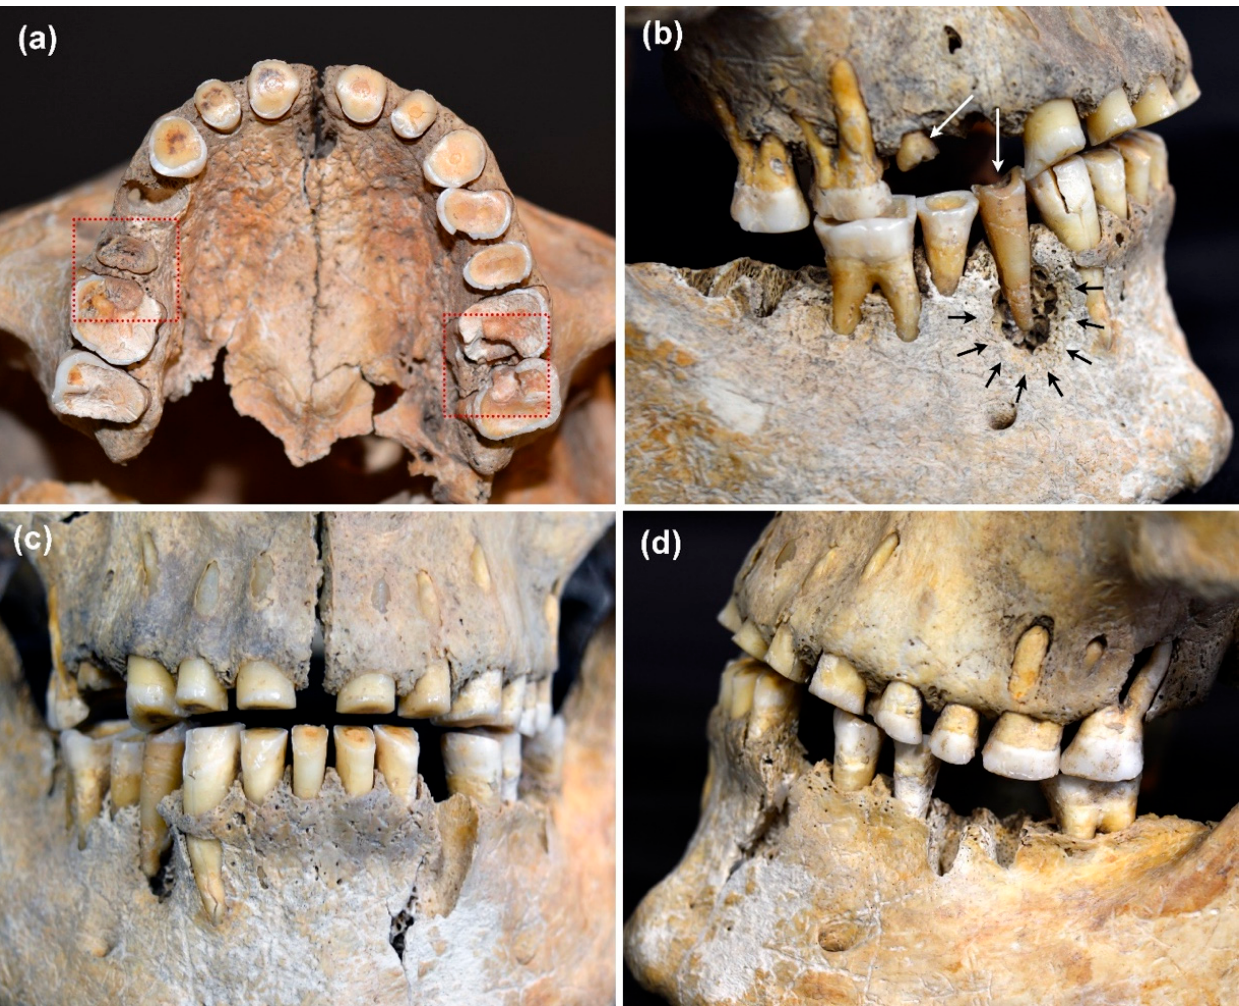
Figure 3. ( a – d ). Dentition of an adult male individual (ID 484) from DEB ( a ) In the upper molars (teeth 16, 26, 27), the carious lesions appear to originate in the interdental spaces (approximal caries; red rectangles). ( b ) In the two premolars (teeth 15, 44) in the right upper and lower jaw (white arrows), the crowns are destroyed, and the origin of the carious lesion cannot be reconstructed. The area around the first mandibular premolar (tooth 44) shows traces of an abscess (black arrows). ( c ) Dental wear is particularly pronounced in the anterior dentition. Incisors and canines of both maxilla and mandible show formation of secondary dentin (cf. ( a )). ( d ) There is evidence of periapical changes on molars 26 and 27. Teeth 33, 36, and 47 were taken for DNA analyses, tooth 14 was lost post-mortem (DEB 484, 35–45 years,